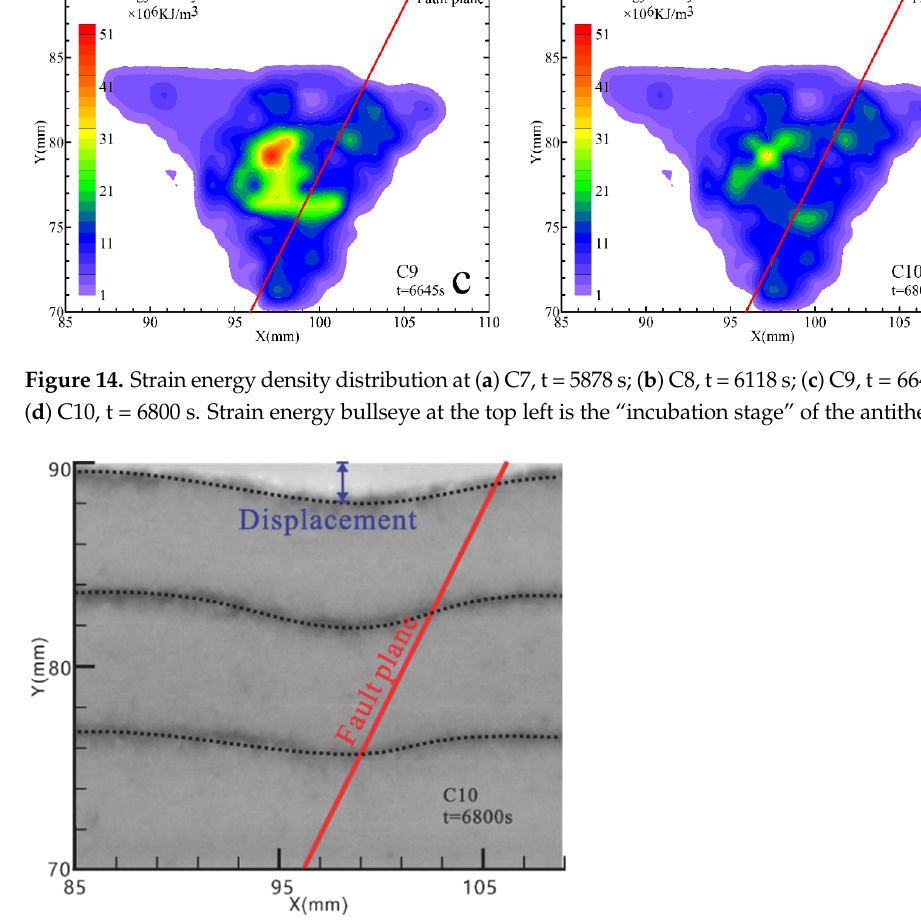
Figure 15. The cross-sectional image from the simulation chamber at C10, t = 6800 s.